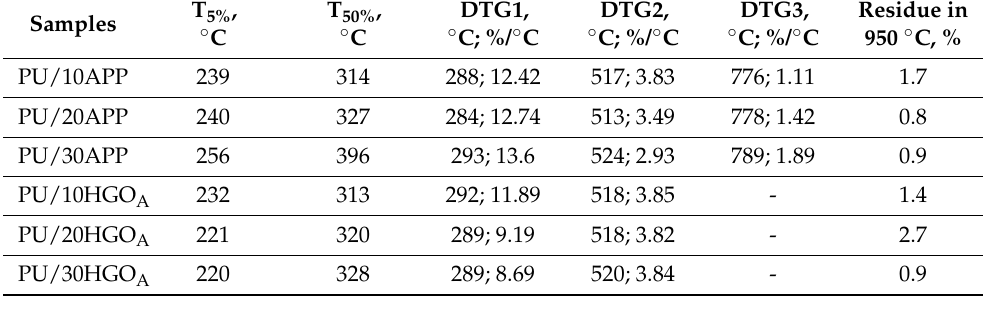
Table 6. TG and DTG data of polyurethane foams with APP or HGO A system. Samples